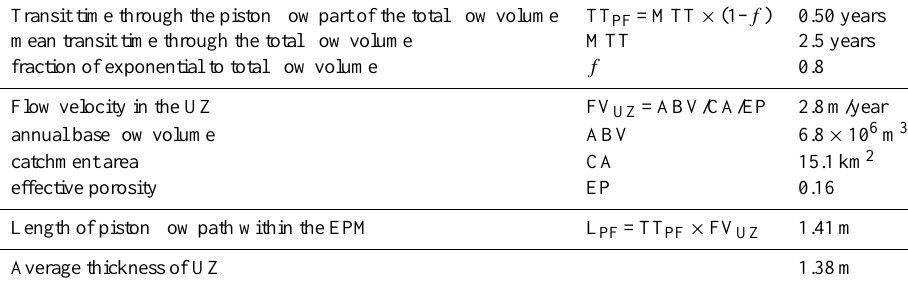
Table 3. Hydraulic parameters for the Toenepi catchment at winter baseflow